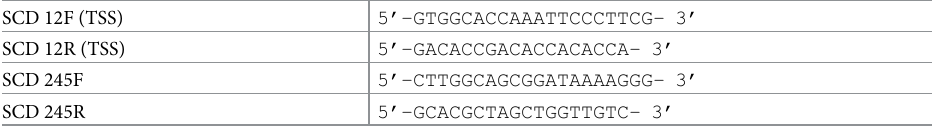
Table 2. Primers used for